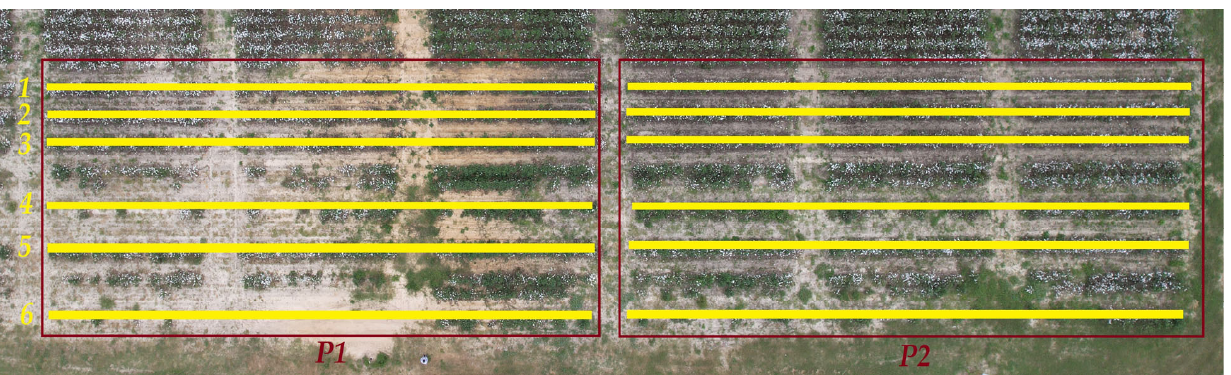
Figure 3. Cotton planted in Field 1 with 6 rows and 2 groups.